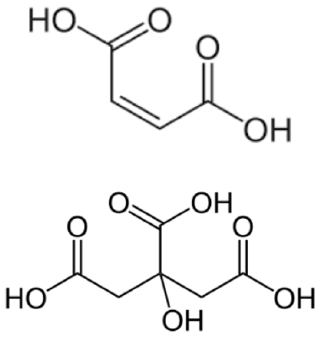
Figure 4. Chemical structure of Citric-acid, and